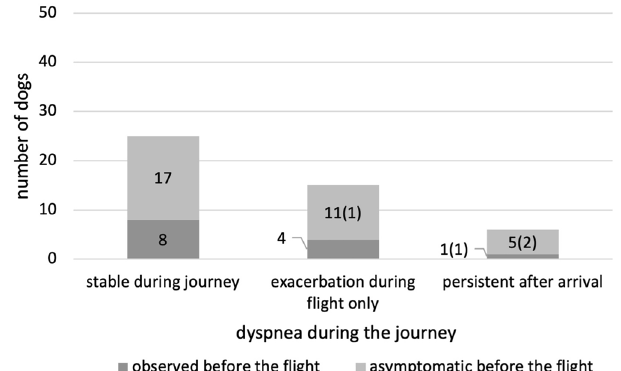
Figure 4. Dyspnea during the journey. More than half of the patients were able to travel in a stable respiratory state regardless of their abnormal respiratory state before the journey. In contrast, approximately half of the patients were suspected to have had a change in respiratory status due to travel. Of note, all dogs that had a cardiac event after the flight had an onset or exacerbation of